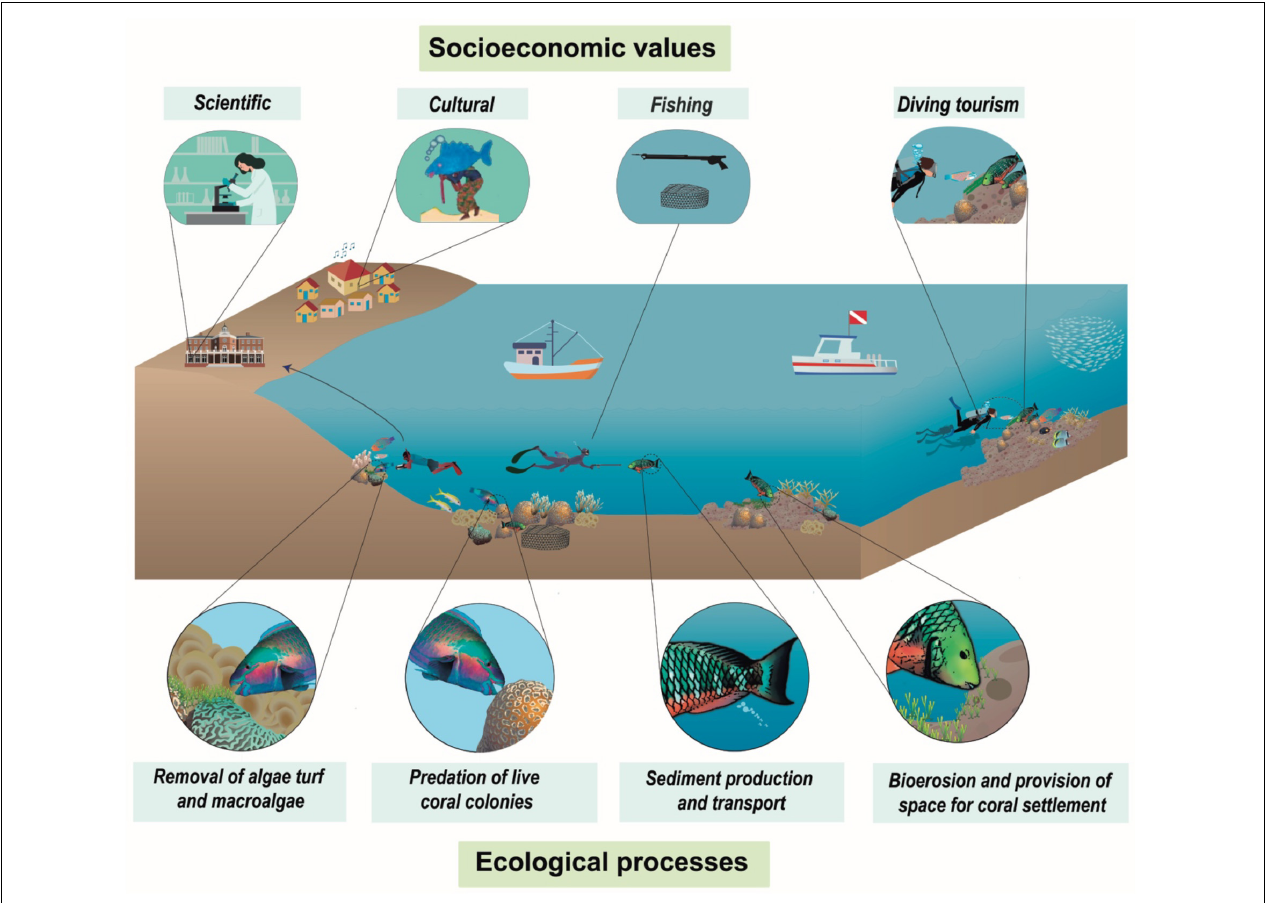
FIGURE 1 | Socioeconomic values and ecological processes related to parrotfishes. Symbols courtesy of the Integration and Application Network